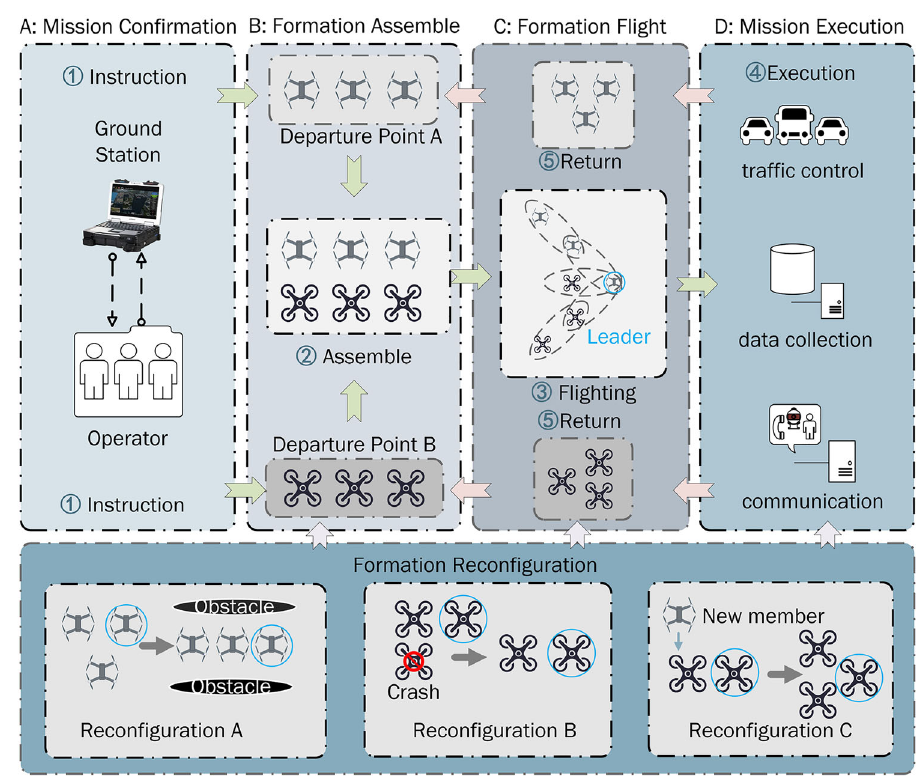
Fig. 1 Application scenario for multi-UAV formation